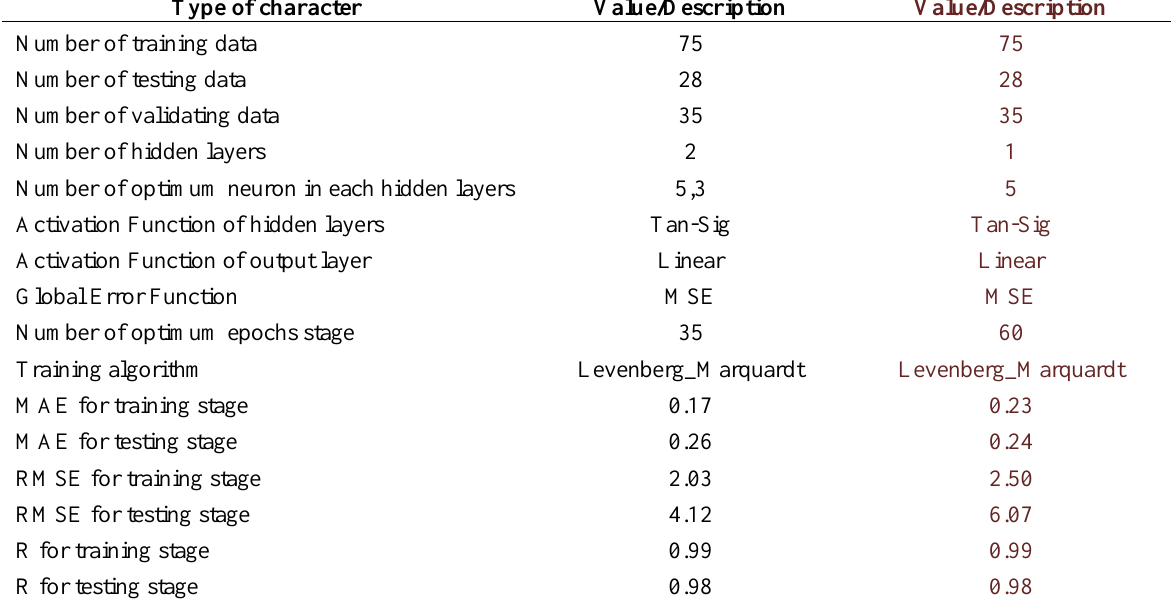
Table 2. Characteristics of ANN’s